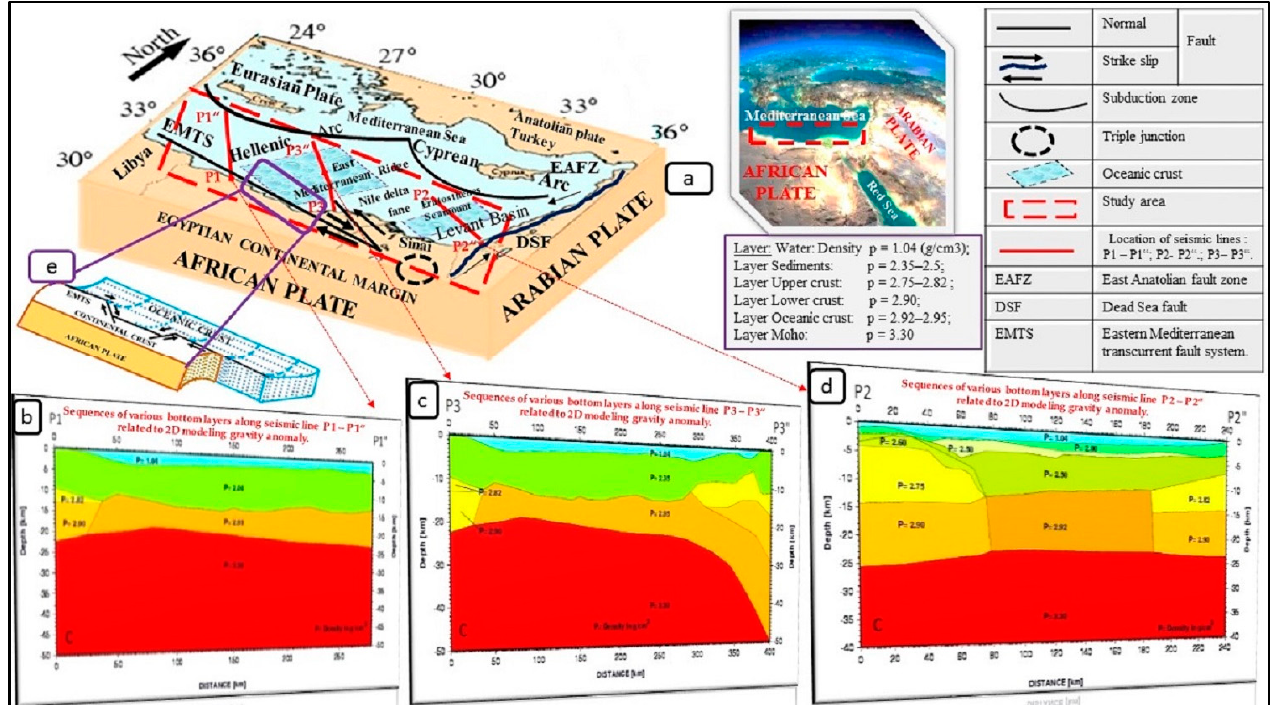
Figure 7. ( a ) Showing simplified geological tectonic model of the major geological structure in the study area and its adjacent areas. Based on [8,9,18–22]. ( b – d ) The main results of the current study showing sequences of various bottom layers along seismic lines P1–P1 ″ , P2–P2 ″ , and P3–P3 ″ related to 2D modeling gravity anomaly, respectively (See, Figures 4–6). ( e ) Showing a tectonic model of the active EMTS at the Egyptian continental margin.